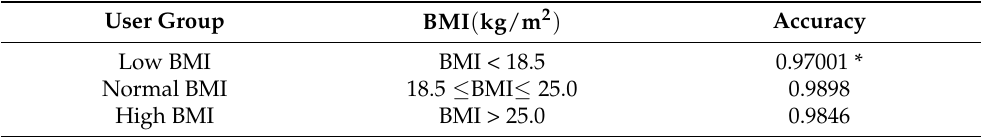
Table 4. Accuracy divergence based on user BMI. * p < 0.01 Wilcoxon signed rank